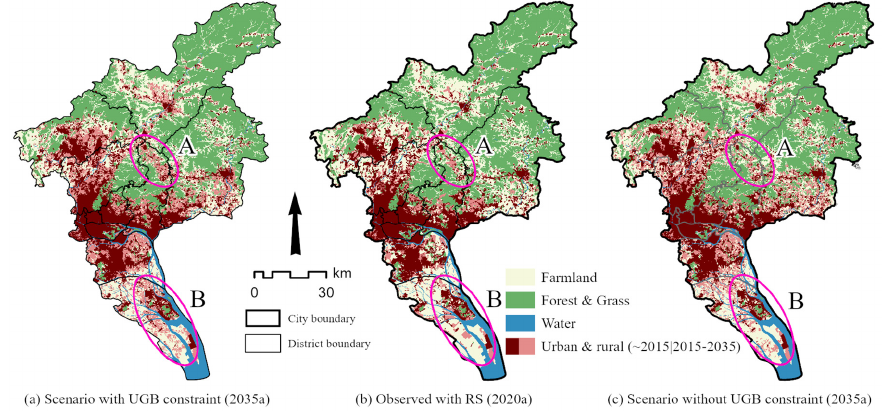
Figure 4. Comparison of urban growth patterns under different scenarios.